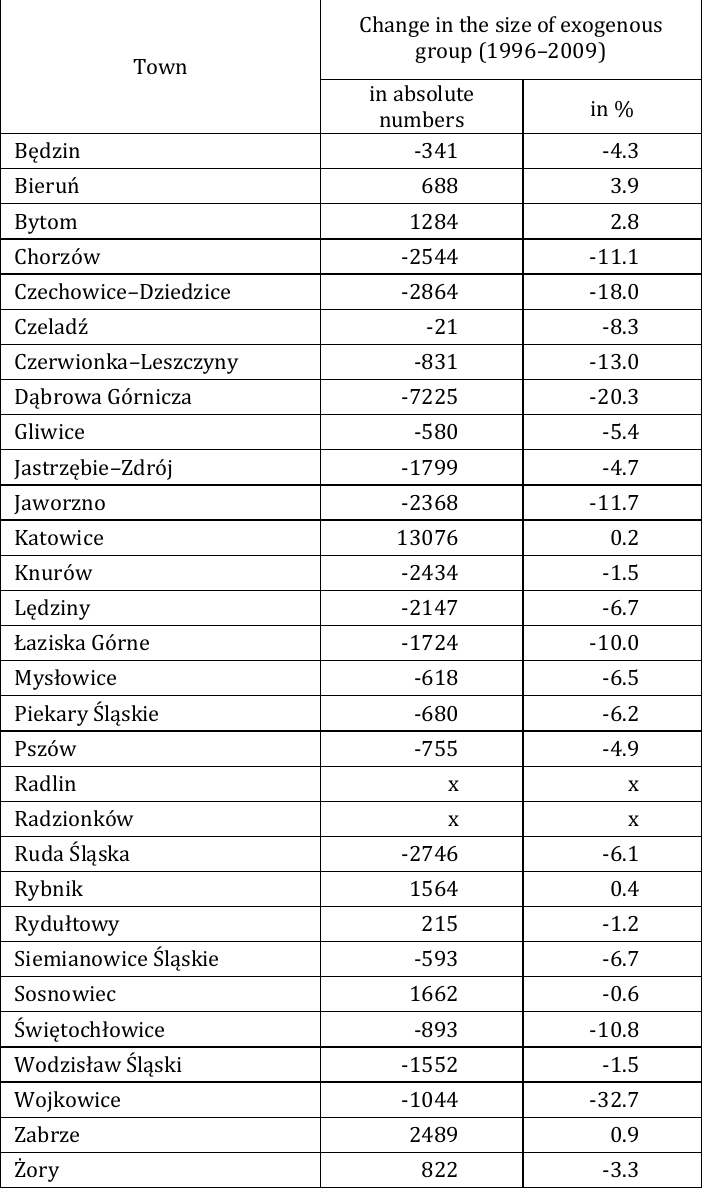
Table 4. Changes of the exogenous function in mining towns of the Silesian